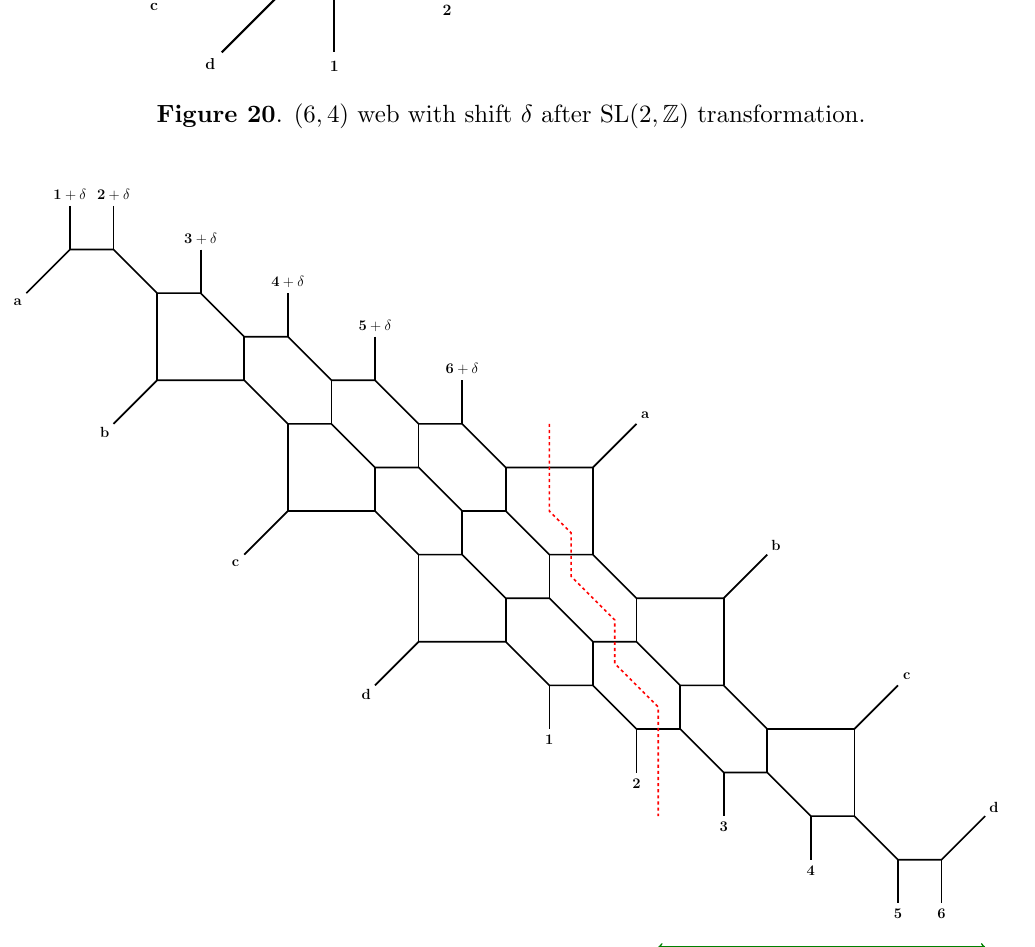
Figure 21 . Web diagram after a (cid:13)op transformation of the diagonal lines in (cid:12)gure 20.